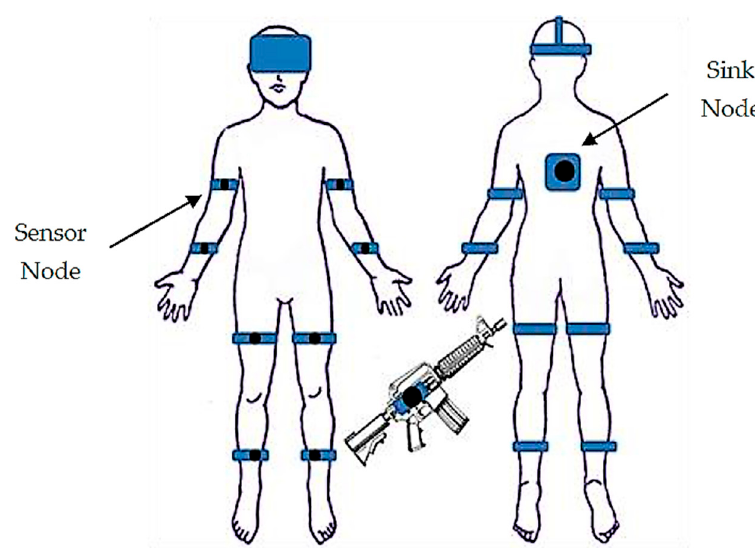
Figure 4. Deployment of sensor nodes and the sink node.